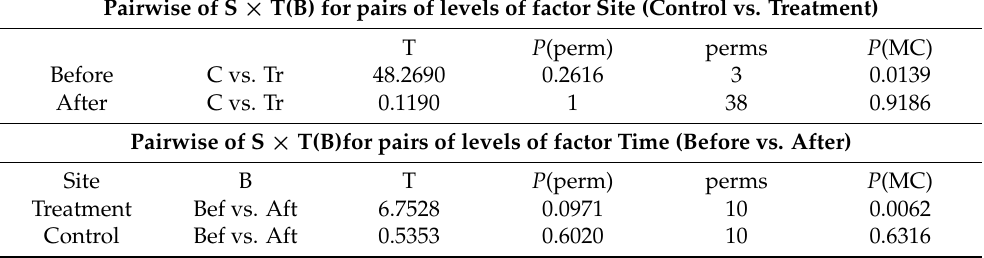
Table 8. Pairwise PERMANOVA on Pielou’s evenness index ( J’ ) of benthic assemblages of Treatment and Control sites at Before (T1, T2) and three After (T3–T5) the bioremediating action. Pairwise of S × T(B) for pairs of levels of factor Site (Control vs. Treatment)